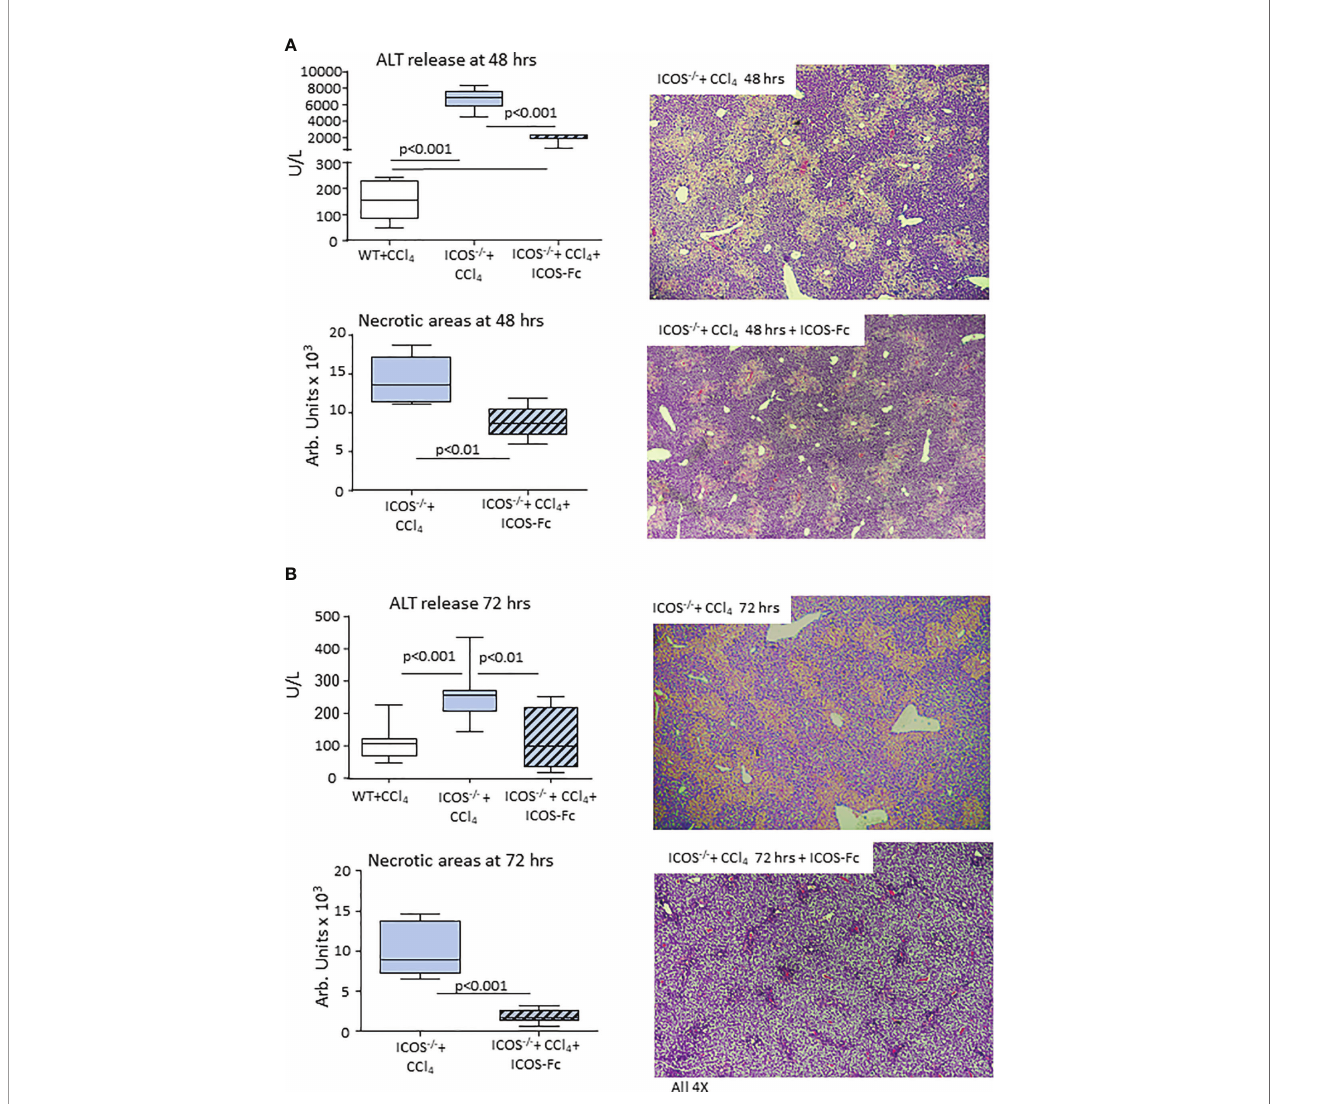
FIGURE 9 | Mice supplementation with recombinant ICOS improves the recovery from acute liver injury. Wild-type and ICOS -/- mice received CCl 4 for 48 (A) or 72 hours (B) and the recovery from liver injury was evaluated by measuring alanine aminotransferase (ALT) release and by morphometric evaluation of necrotic areas in liver sections stained with hematoxylin/eosin (magni fi cation 4X). The results are expressed as mean ± SD of 5-6 animals for each time